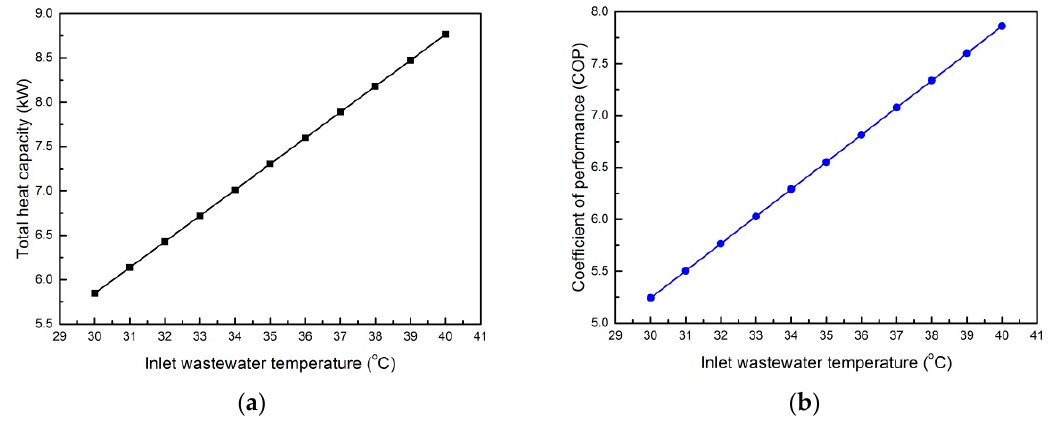
Figure 4. Influence of inlet wastewater temperature on total heat capacity and coefficient of performance (COP): ( a ) Total heat capacity; ( b ) COP.